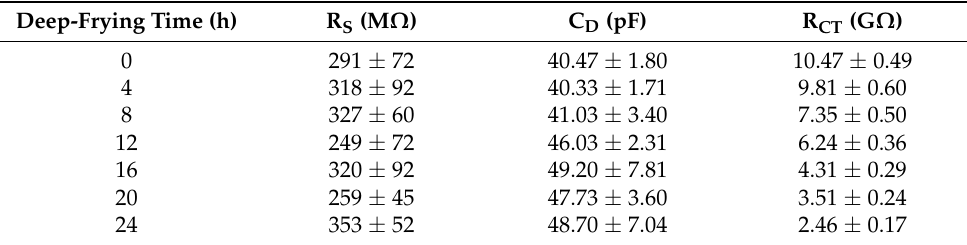
Figure 3. Nyquist diagrams of palm oil during deep-frying process: ( (cid:4) ) fresh oil, ( (cid:3) ) after 4 h, ( (cid:78) ) after 8 h, ( ∆ ) after 12 h, ( • ) after 16 h, ( ) after 20 h, and ( (cid:7) ) after 24 h deep-frying of French (cid:35) fries. The inset shows the equivalent circuit model. The configuration of the electrochemical cell was geometry #5 (refer to Table 1: electrode No. CC-GRP-2, 10 mm in diameter). Applied potential: 0 V; amplitude: 100 mV; frequency range: 1–0.01 Hz; temperature: 30 ◦ C. Table 2. Impedance analysis of palm oil during deep-frying process based on the simplified Randles equivalent circuit model without the Warburg diffusion